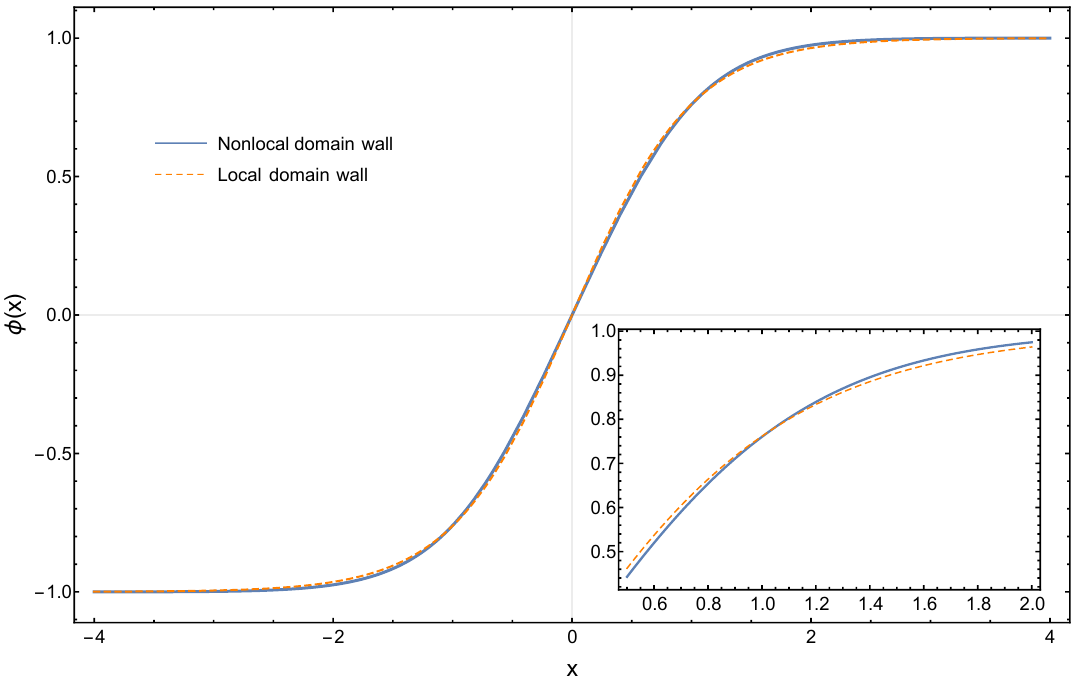
Figure 2 . In this figure we show the linearized nonlocal domain wall solution φ ( x ) = φ L ( x ) + δφ ( x ) (solid blue line) in comparison with the local domain wall (orange dashed line). The nonlocal configuration approaches the asymptotic vacua at x → ±∞ faster as compared to the local case. In the smaller plot we showed the behavior of the two solutions over a smaller interval in order to make more evident the differences between local and nonlocal cases. We can notice that when going from x = 0 to x → ±∞ the nonlocal curve slightly oscillates around the local one. We set λ = 2 , = 14 . 3 , which are consistent with the theoretical constraint M 2 v = 1 and M 2 s in eq.